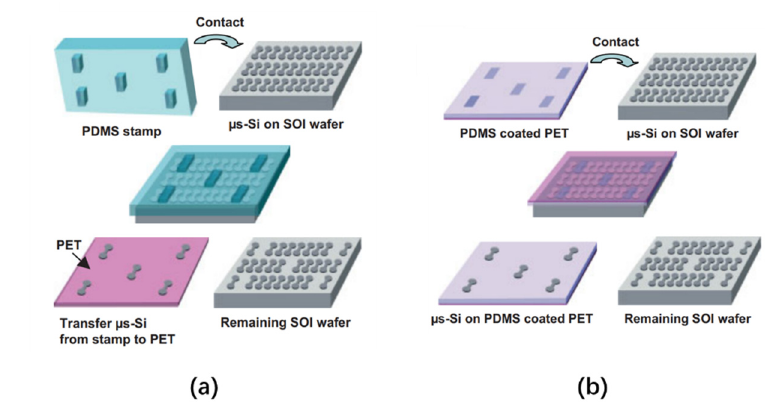
Figure 3. ( a ) The transfer printing step using polydimethylsiloxane (PDMS) and ( b ) the elastomer stamp transfer step using decal-transfer lithography (DTL) technology. Reproduced from [39], with permission from John Wiley and Sons, 2005.